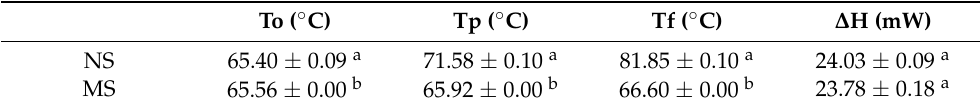
Table 3. Thermal characteristics of native and extrusion modified rice starch obtained with DSC.